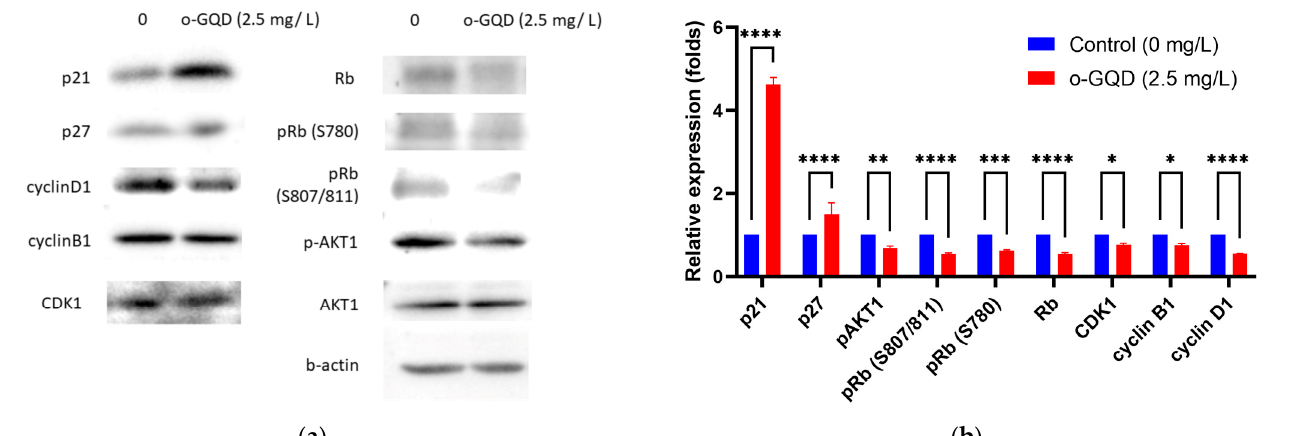
Figure 7. ( a ) Representative Western blot showing the expression of cell cycle-related proteins in MCF-7 cells treated with or without o-GQD for 72, ( b ) and their quantitative evaluation. The data indicate averages from triplicates, and the error bars indicate SD. Significance is determined by using two-way ANOVA statistical analysis. The significant differences are indicated by using *. *: p < 0.05, **: p < 0.01, ***: p < 0.001, ****: p < 0.0001.